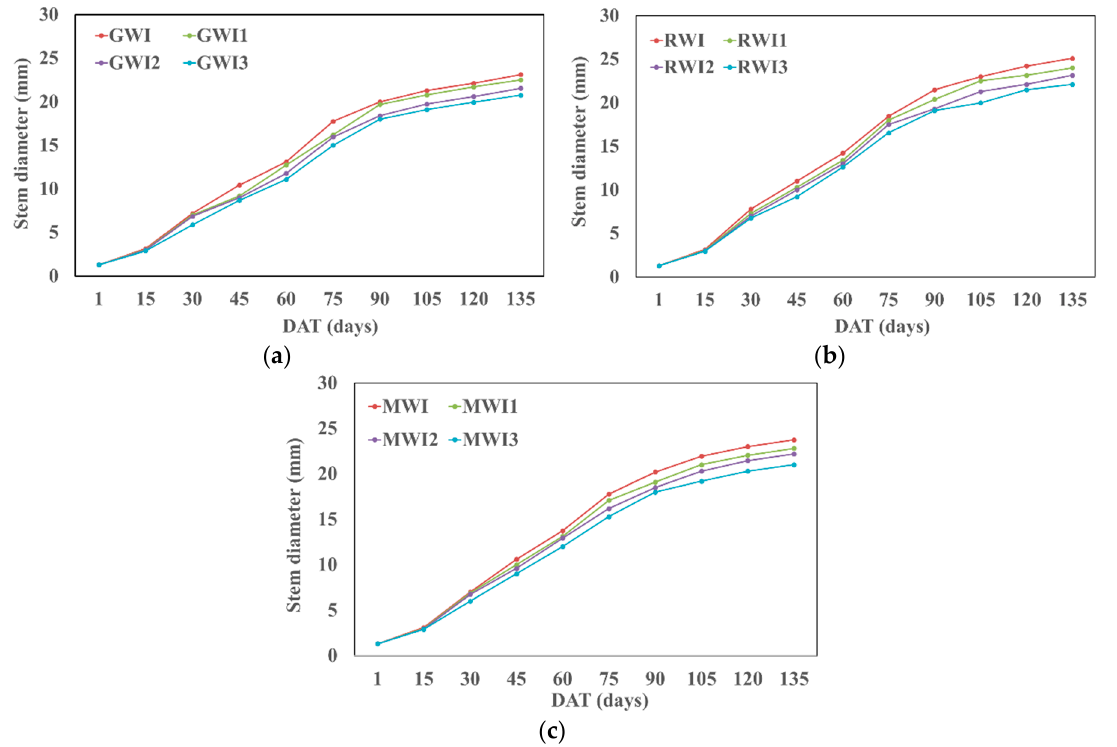
Figure 4. Stem diameter variation under different treatments of GW ( a ), RW ( b ) and MW ( c ) in experimental year 2017–2018.